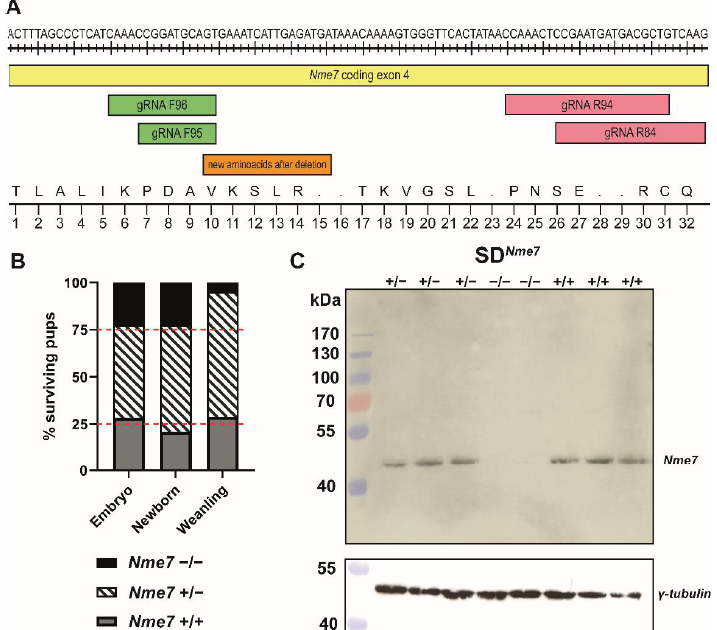
Figure 1. Generation of an Nme7 knock-out Sprague Dawley rat model. ( A ) At the top, part of the sequence of Nme7 , coding exon 4, is shown together with the locations of two sets of guide (g)RNAs. The bottom part of the figure shows the corresponding amino acid sequence (standard one-letter code), indicating its change after the induced deletion. ( B ) Ratio of the genotypes of surviving SD Nme7 rats at three distinct time points (embryo: E13.5–E15.5, newborn: P1, and weanling: P28). The red dashed line corresponds to the expected Mendelian ratio of 25% (SD Nme7+/+ — grey bars):50% (SD Nme7+/ − — striped bars):25% (SD Nme7 − / − — black bars). ( C ) Western blot showing the lack of Nme7 protein in SD Nme7 − / − rat testes. Stripped membrane was used for γ -tubulin protein detec- tion.